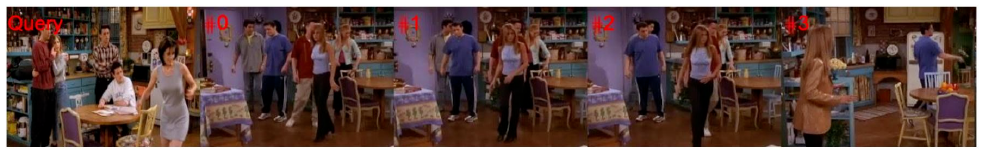
Figure 5. An example of utilising the spatial similarity matrix to retrieve top four similar frames from a video. The video used is Season 5 Episode 21 of FRIENDS